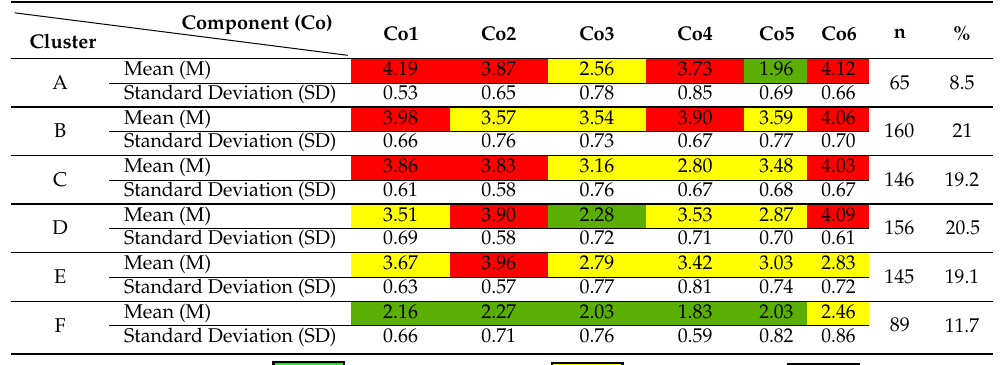
Table 4. E-Learning challenges based on cluster.